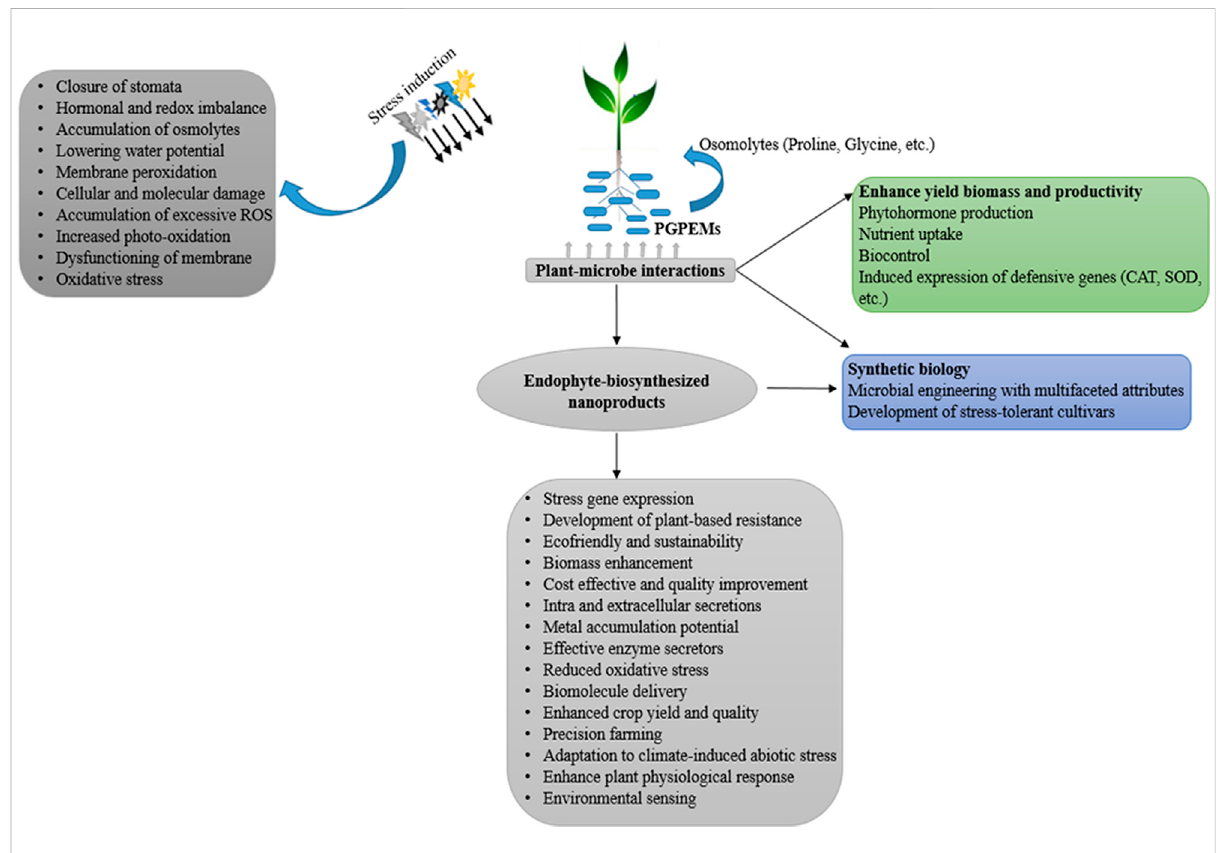
FIGURE 1 Concept of endophyte interactions and biosynthesized nanoproducts to alleviate abiotic stress and enhance crop